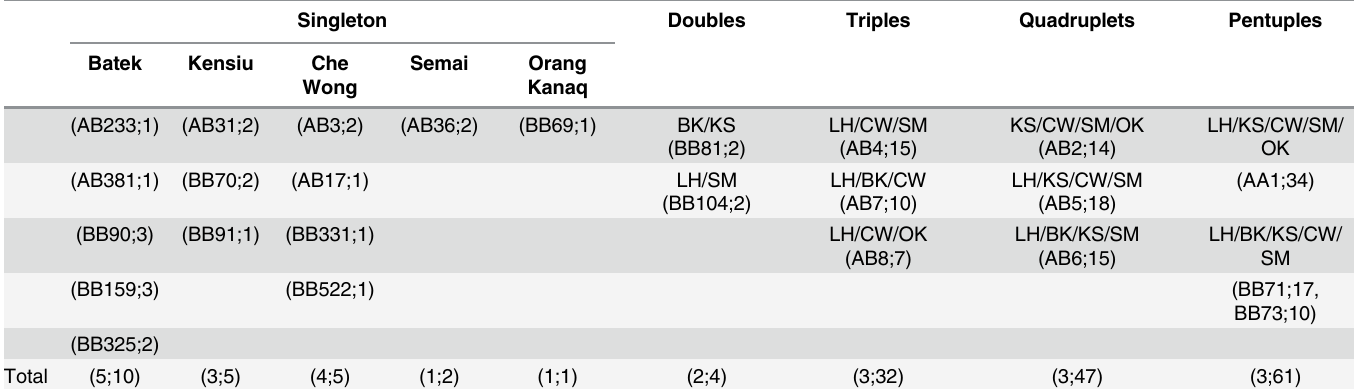
Table 2. The distribution of unique and shared KIR genotypes between OA subgroups.